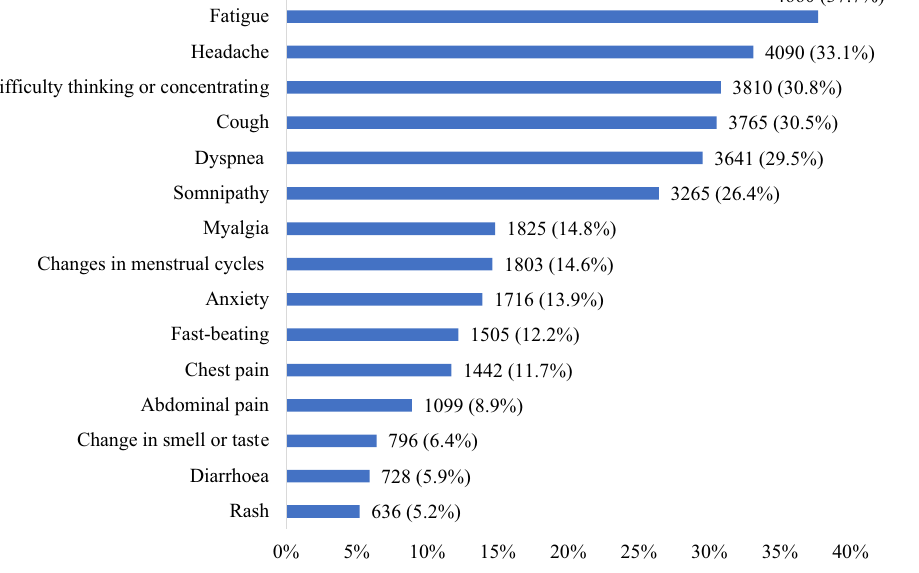
Figure 1. Prevalence of post-COVID-19